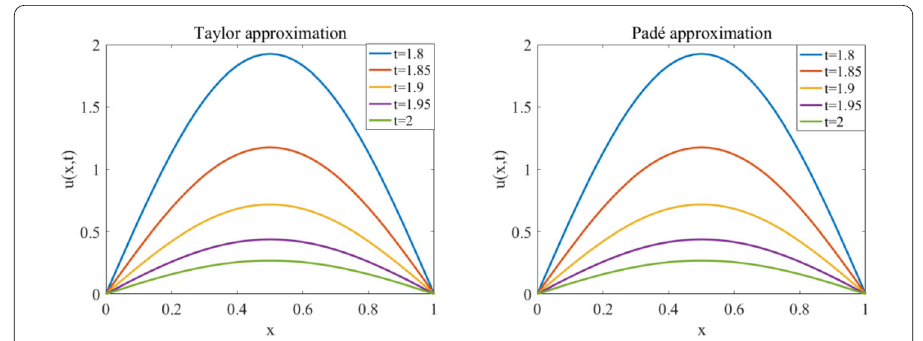
Figure 5 The numerical solutions of the Taylor approximation and Padé approximation of CFDS-PIM for case 1 of Example 1